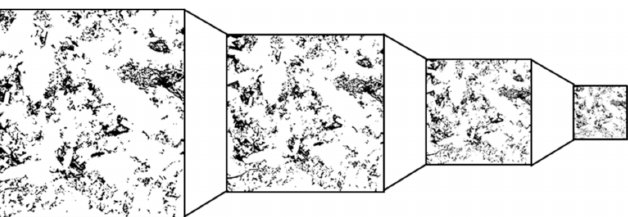
Figure 3. Varying resolution structures obtained from coarsening operation. The sample size is N = 1000 and resolution ratio changes from R = 1.0 to R = 0.25 with a step of 0.25. Pores are shown in black and solid in white. Only a 2D slice is presented in the